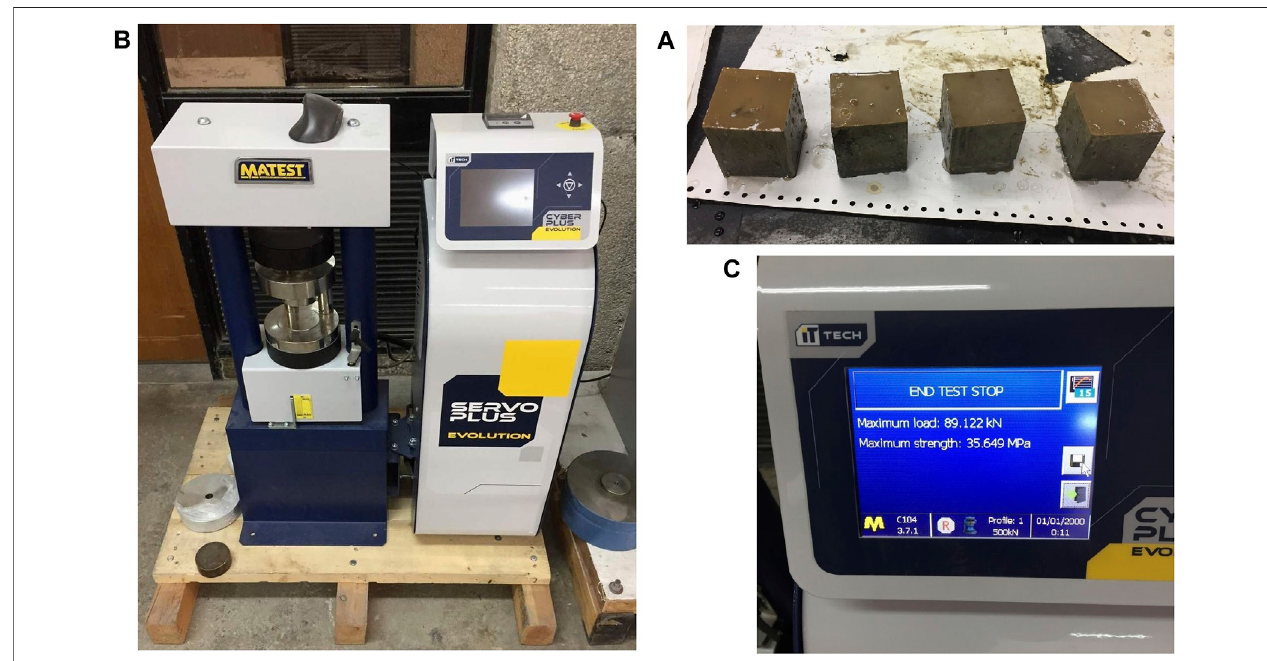
FIGURE 3 | Cement specimens, uniaxial loading equipment, and UCS test result sample. (A) is a batch of demolded cured cement specimens. (B) is a set of uniaxial loading equipment to do the crushing test. (C) is a screen shot of one UCS test result sample.